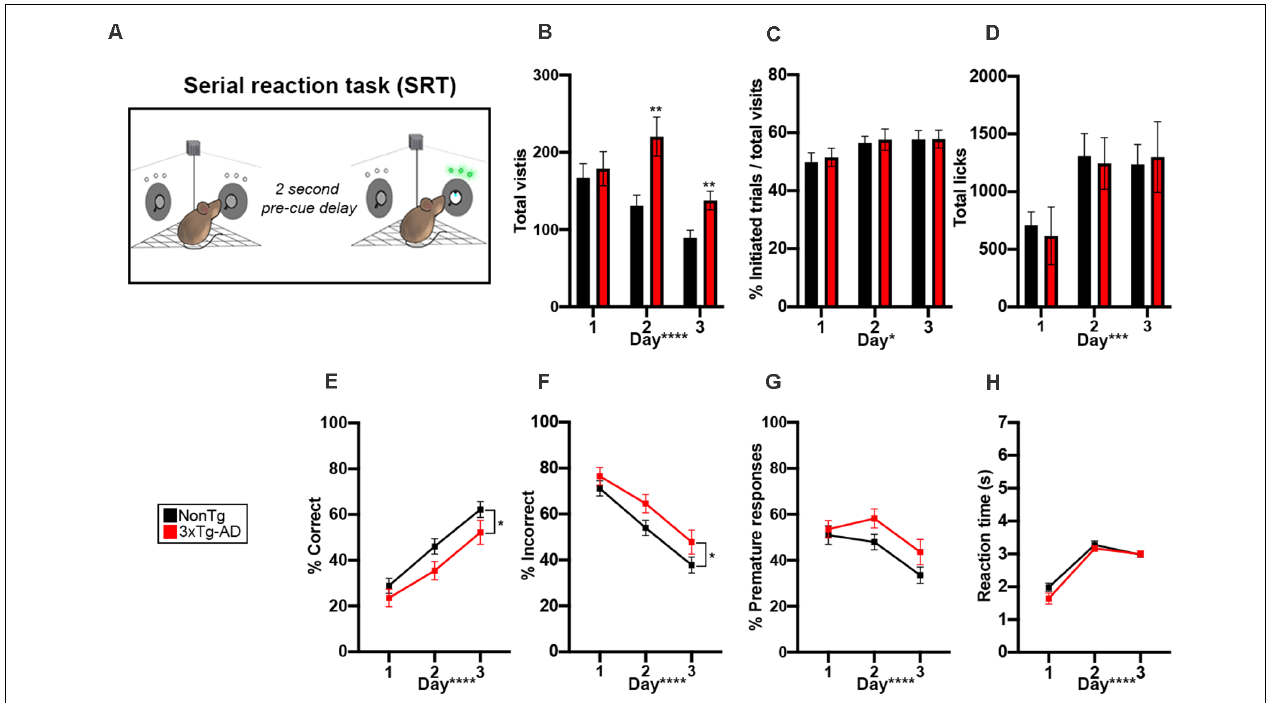
FIGURE 4 | 3xTg-AD mice showed impairments in attention in the Serial reaction time (SRT) attention tasks. (A) During the 6 days of the SRT task, animals were required to enter an assigned corner and nosepoke to initiate a trial. Then, a 2-s pre-cue delay was initiated and animals needed to learn to wait for the cue illumination. A green LED illuminated in one of the two noseports and the animal had 7 s to extinguish the LED with a nosepoke. A correct response resulted in access to water, while a premature (during 2-s delay) or incorrect response reset the trial and the animal was required to leave the corner before initiating a new trial; corner not drawn to scale. (B) 3xTg-AD mice made more total visits to all corners on day 2 ( p < 0.01) and 3 ( p < 0.01) of testing. Total visits went down across the 3 days of testing ( p < 0.0001). (C,D) The number of initiated trials ( p < 0.05) and total licks ( p < 0.001) went up across the 3 days of testing. (E) % correct increased throughout the testing days ( p < 0.0001), indicating learning. We found that 3xTg-AD mice had a significantly lower % correct than NonTg counterparts ( p < 0.05). (F) % incorrect decreased throughout the testing days ( p < 0.0001), indicating learning. We found that 3xTg-AD mice had a significantly higher % incorrect than NonTg counterparts ( p < 0.05). (G,H) % premature responses decreased ( p < 0.0001) and reaction time to extinguish the LED ( p < 0.0001) increased across the 3 days. Data are presented as means ± SEM. * p < 0.05, ** p < 0.01, *** p < 0.001, **** p <